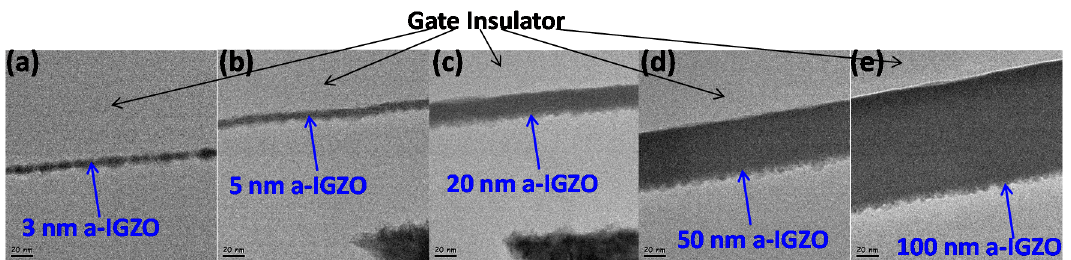
Figure 2. Transmission electron microscope images of parts of thin-film transistors with amorphous indium-gallium zinc-oxide thickness of ( a ) 3 nm, ( b ) 5 nm, ( c ) 20 nm, ( d ) 50 nm, and ( e ) 100 nm.